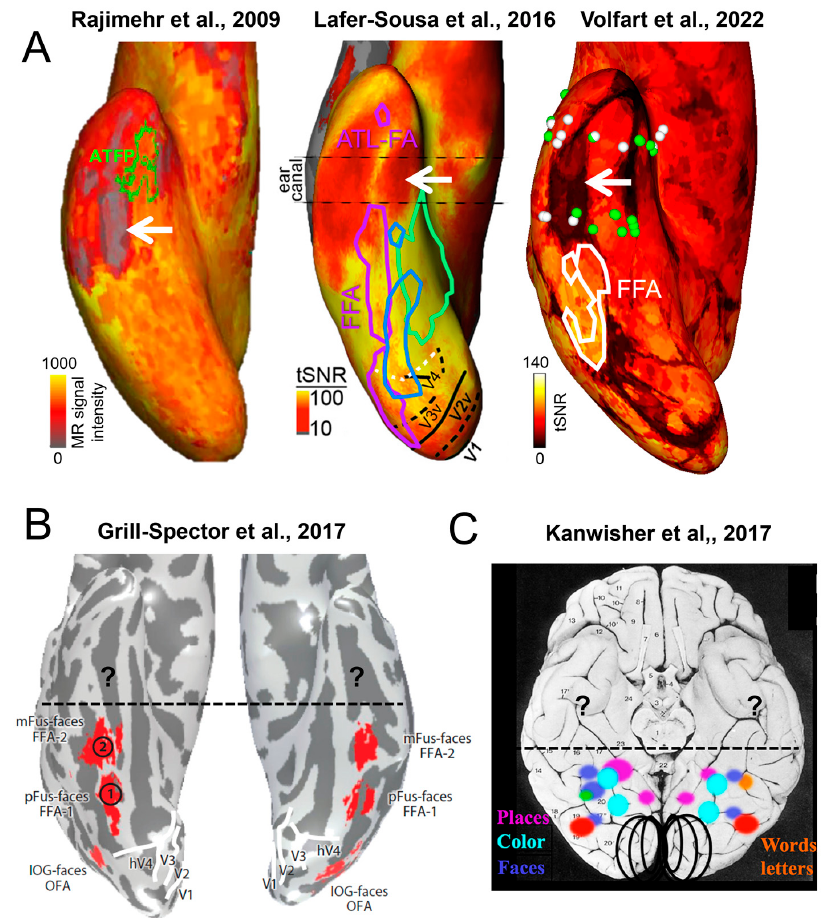
Figure 7. Magnetic susceptibility artifact due to the ear canal (or vATL signal dropout) in fMRI and its consequences on the current picture of fMRI neural basis of human face recognition. ( A ) These examples show the BOLD signal level and tSNR on ventral views of the inflated cortical surface. The vATL signal dropout is indicated by a white arrow (gray or black zone in Rajimehr et al., 2009 [101]; and in Volfart et al., 2022 [97]; red zone in Lafer-Sousa et al., 2016 [104]; reproduced with permission). In these regions, BOLD measurements are not reliable. Note that face-selective activations (green outlines in Rajimehr et al., 2009, purple in Lafer-Sousa et al., 2016, and white in Volfart et al., 2022) are found all along the VOTC except in the region of the signal dropout. On the contrary, SEEG, which is not affected by SNR variations, is still able to capture face-selective response in this region (green dots in Volfart et al., 2022). ( B ) Topological organization of the face-selective activations in the VOTC (red spots) in one of the most recent reviews on the functional architecture of face perception in the VOTC (Grill-Spector et al., 2017, [66]). Note that there are no activations anteriorly to the middle fusiform gyrus (FFA, spot indicated by “2” in the figure). ( C ) Schematic representation (from Kanwisher, 2017 [67]) of the progress made in the understanding of the functional architecture of the VOTC between 1990 (birth of fMRI) and 2017. Although the posterior VOTC is refined (see colored spots representing schematic category-selective regions), little or no progress appears to have been made in mapping anterior VOTC regions with